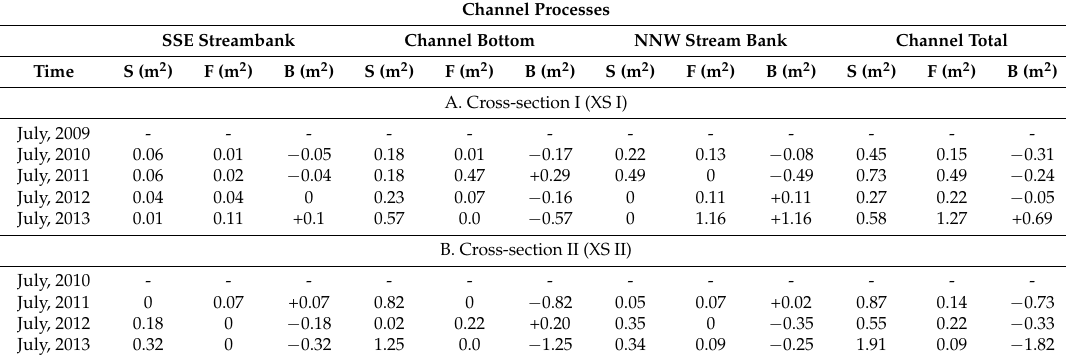
Notes: S—scour, F—fill, B—balance.